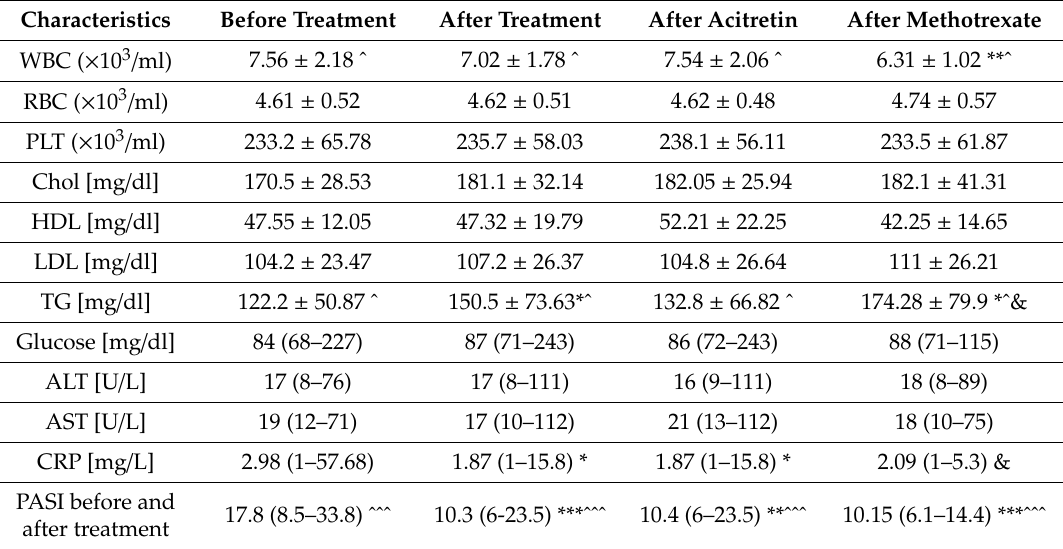
* / ** / *** means the existence of statistically significant di ff erence between values after and before treatment with p < 0.05; p < 0.01; p < 0.001, respectively. ˆ / ˆˆˆ means the existence of statistically significant di ff erence between all the 4 groups calculated using ANOVA with p < 0.05; p < 0.001, respectively. & means the existence of trend due to low n per subgroup. PASI, psoriasis area and severity index; RBC, red blood cells; PLT, platelets; WBC, white blood cells; TG, triglycerides; HDL, high-density lipoproteins; LDL, low-density lipoproteins; CRP, C-reactive protein; ALT, alanine transaminase; AST, asparagine transaminase.